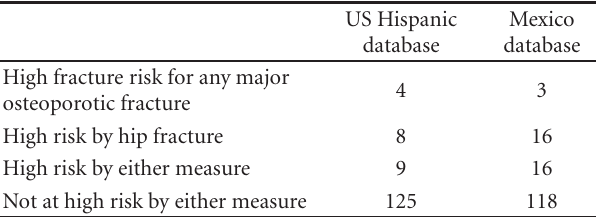
Table 2: Number of subjects meeting NOF interventional threshold limits.